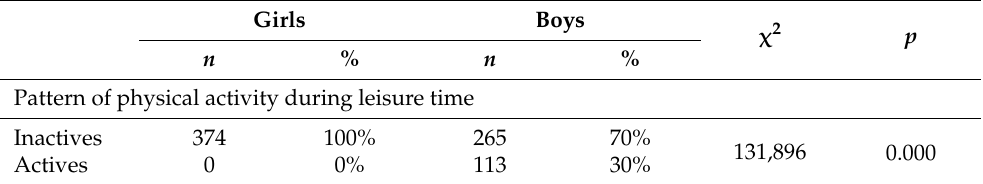
χ 2 p 131,896 0.000